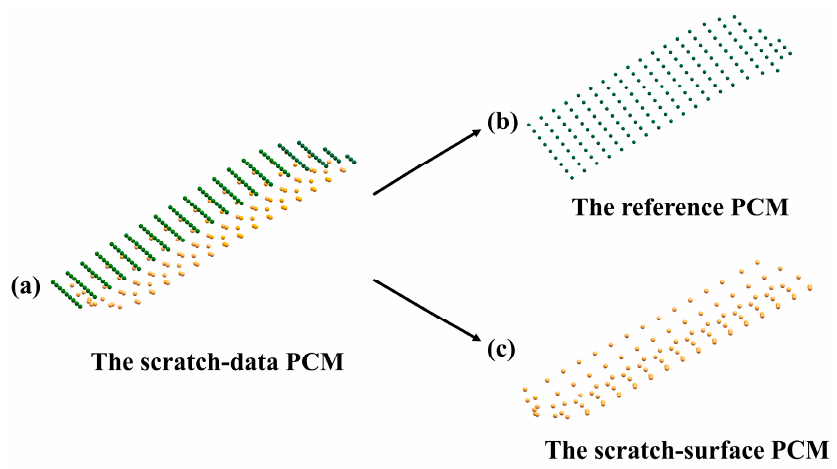
Figure 12. The composition of the scratch-data PCM. ( a ) The scratch-data PCM; ( b ) The reference PCM; ( c ) The scratch-surface PCM.